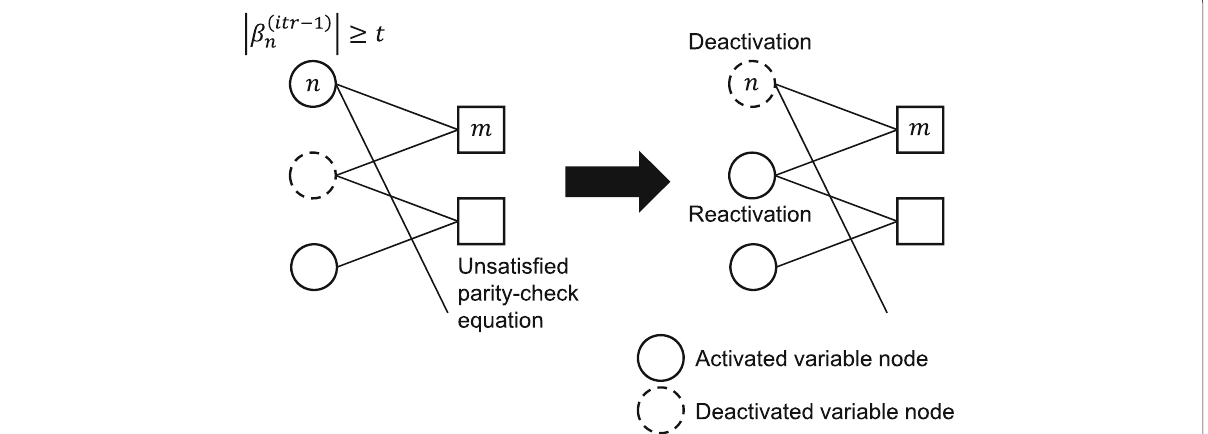
Fig. 1 Behavior of the FC algorithm, including deactivation and reactivation; variable nodes whose absolute value of APP-LLR is greater than a threshold t are deactivated. The deactivated variable nodes are reactivated when they are found in the unsatisfied parity-check